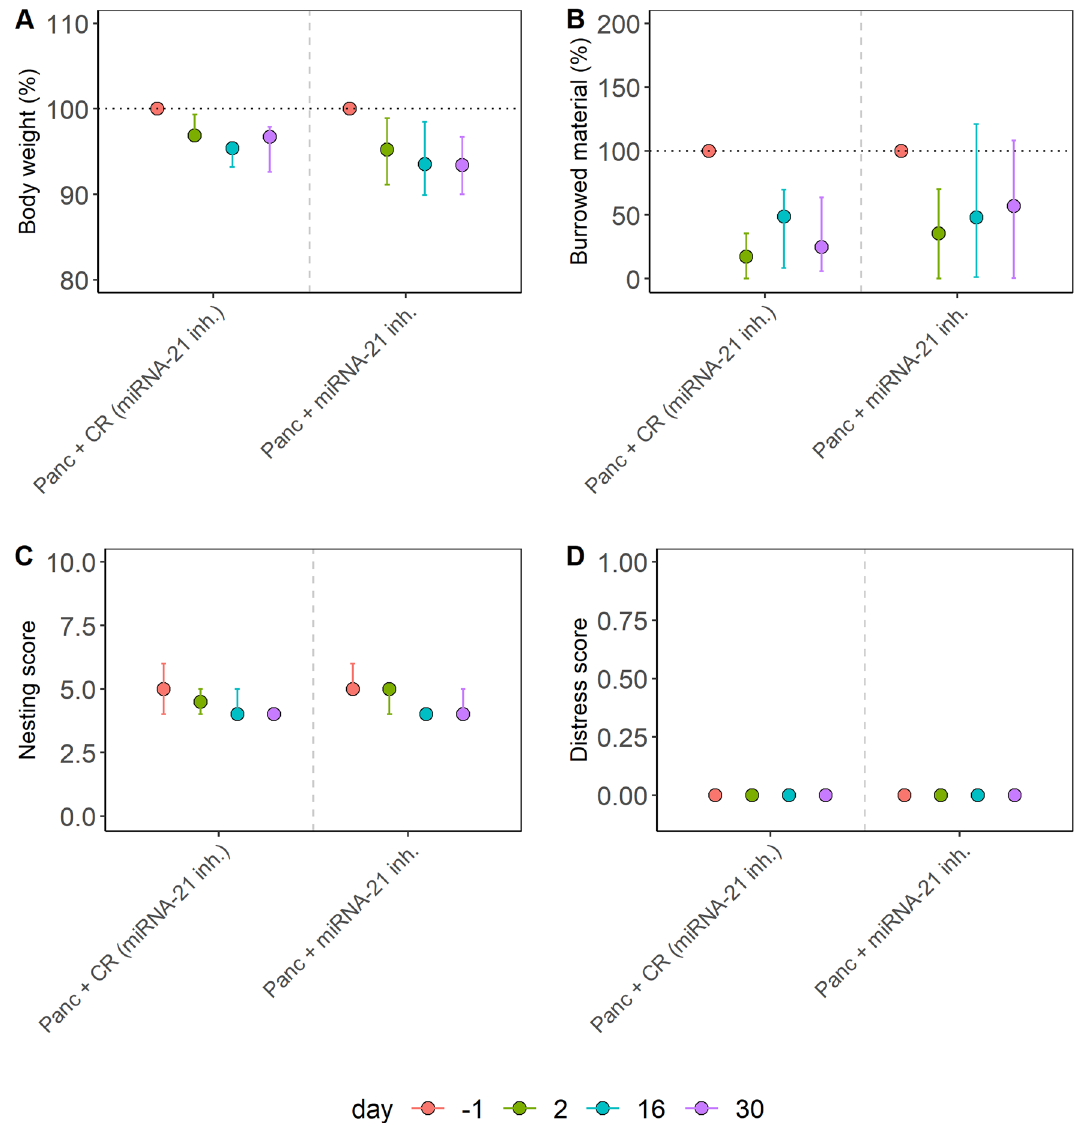
Figure 2. Distress evaluation of a chronic pancreatitis model. Chronic pancreatitis (Panc) was treated with a microRNA-21 inhibitor (miRNA-21 inh.) or the identical vehicle solution plus a respective control oligonucleotide (CR). The percentage of body weight ( A ), the percentage of burrowing activity ( B ), the nesting ( C ), and the distress score ( D ) were assessed on the indicated days. No significant differences between the two groups were determined using the Kruskal–Wallis test in ( A ) ( χ 2 = 0.82, df = 1, p = 0.36), ( B ) ( χ 2 = 0.97, df = 1, p = 0.32), ( C ) ( χ 2 = 0.45, df = 1, p = 0.5) or ( D ) ( χ 2 = 0.44, df = 1, p = 0.50). The graphs depict the bootstrapped median estimator on each experimental day and the 95% confidence intervals. ( A – D ) Panc + CR (miRNA-21 inh.) n = 8, Panc + miRNA-21 inh. n =